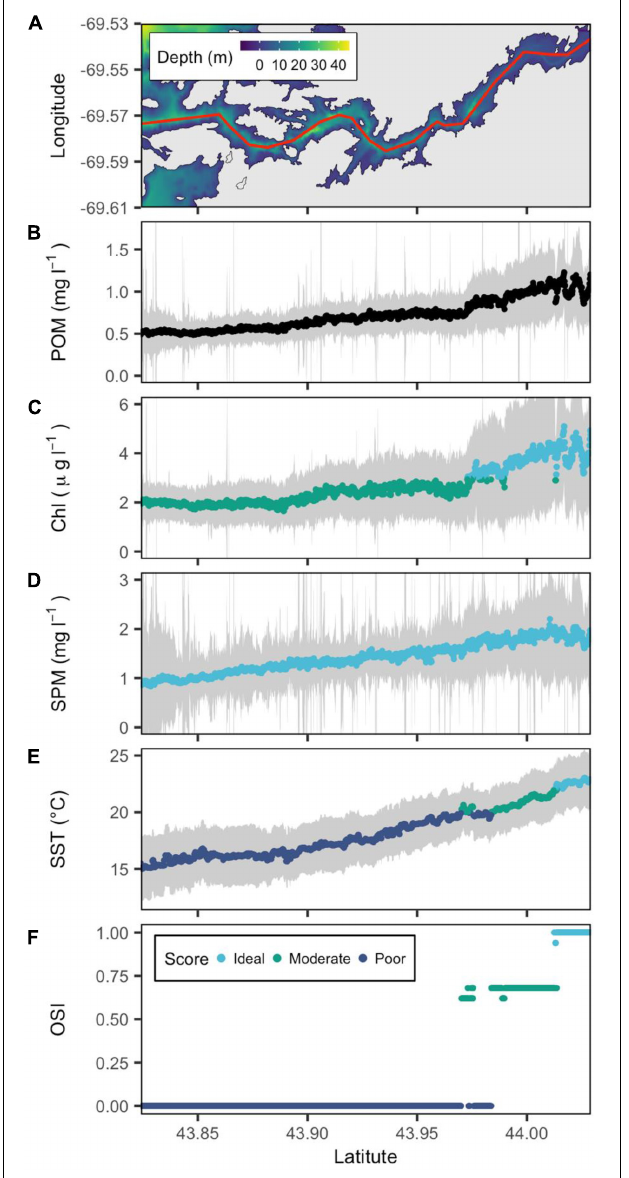
FIGURE 3 | Bathymetric map of the Damariscotta River estuary (from downstream to upstream left to right) with a red line showing the central transect. (A) POM (B) , SPM (C) , Chl a (D) , and SST (E) are reconstructed from remote sensing data, and OSI (F) is derived following the method of Snyder et al. (2017). Gray color belts show standard deviation of POM, SPM, Chl a, and SST derived in summer (June–September) over the period 2016–2020, with their median values depicted by blue, green, and cyan points that denote poor, moderate and ideal conditions for oyster aquaculture, respectively.